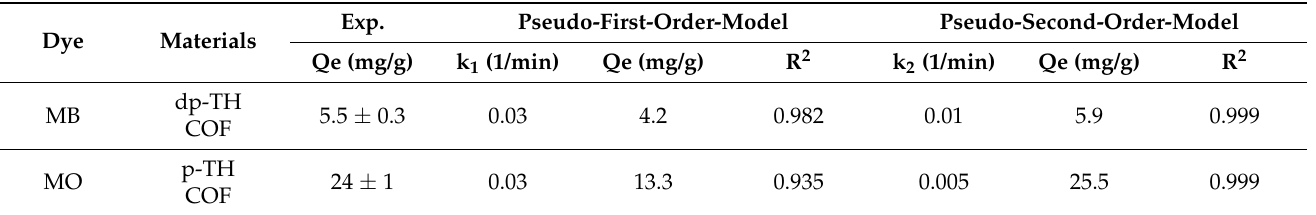
Table 1. Pseudo-first-order and pseudo-second-order constants and correlation coefficients for the absorption of MB and MO dyes by dp-TH and p-TH COFs,